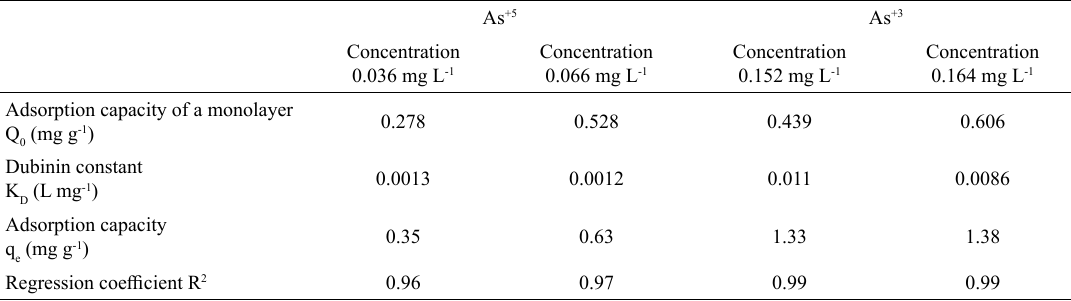
Table 7: Results from the Dubinin model for the adsorption of As ions (As +3 y As +5 ) on the MNPs.